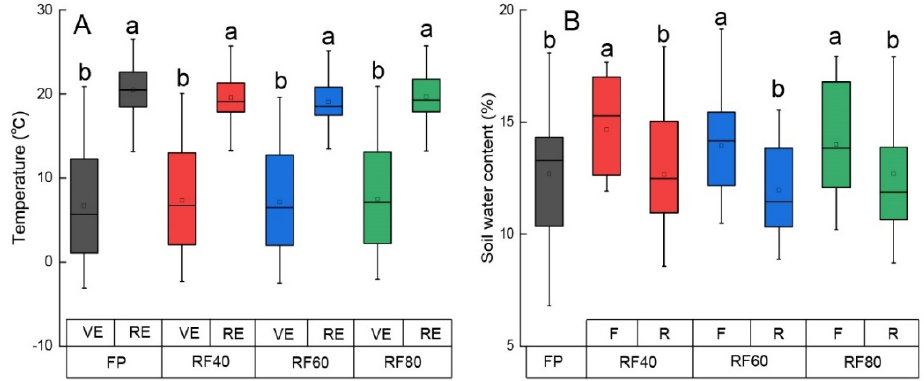
Figure 3. Soil temperature ( A ) in vegetative (VE) and reproductive (RE) growth periods and soil moisture ( B ) in furrow (F) and ridge (R) under different treatments in 2017–2019. Same lowercase letters indicate data without significant differences at p < 0.05 level.